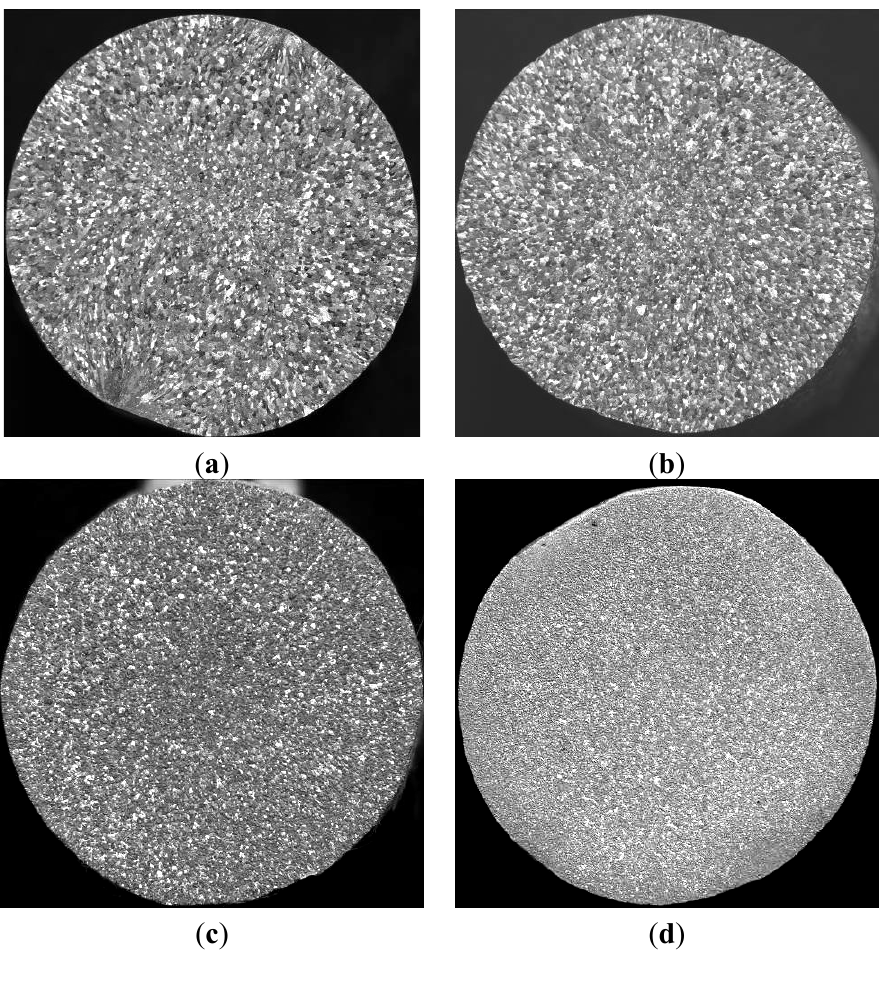
Figure 8. Effects of different additions of Al–5Ti master alloy 2 # on grain size of solidified commercial pure aluminum sample (holding for 5 min): ( a ) 1.0%; ( b ) 1.6%; ( c ) 2.0%; ( d )